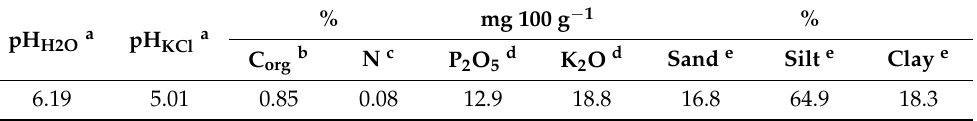
Table 1. Chemical and physical soil properties at the experimental